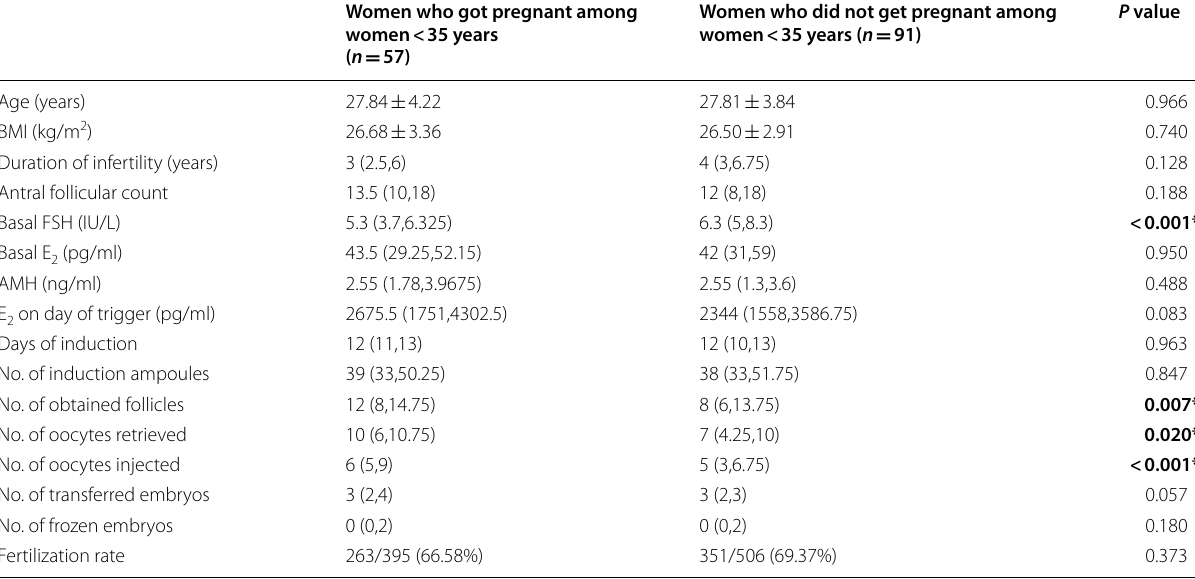
Table 2 Comparison between women who got pregnant and those who did not get (among women < 35 years, group 1)